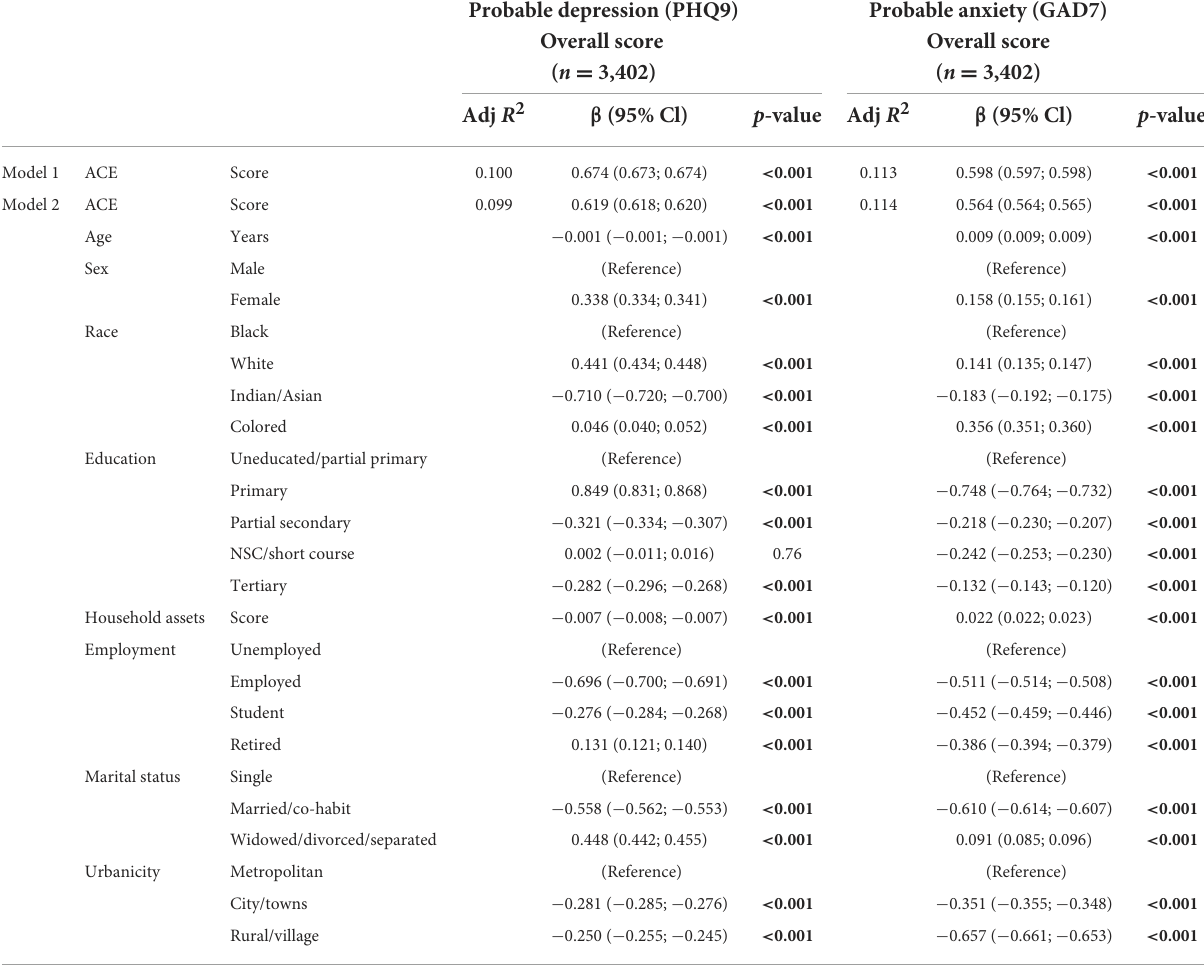
Model1:regressionunadjusted. Model2:regressionadjustedforsocio-demographics. n,numberofparticipants. Boldvaluesdenotestatisticalsignificance(p <